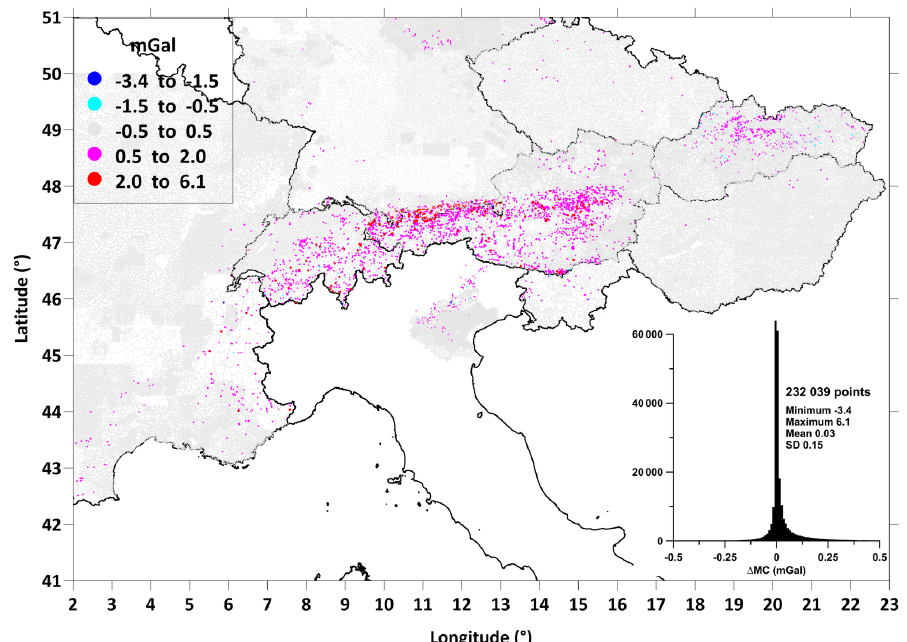
Figure D4. Differences in mass correction values (correction density 2670kgm − 3 ) calculated by local DEMs which are derived mainly from lidar data and the MERIT model. For Italy, the part of the territory is displayed where for test reasons a local high-resolution DEM was